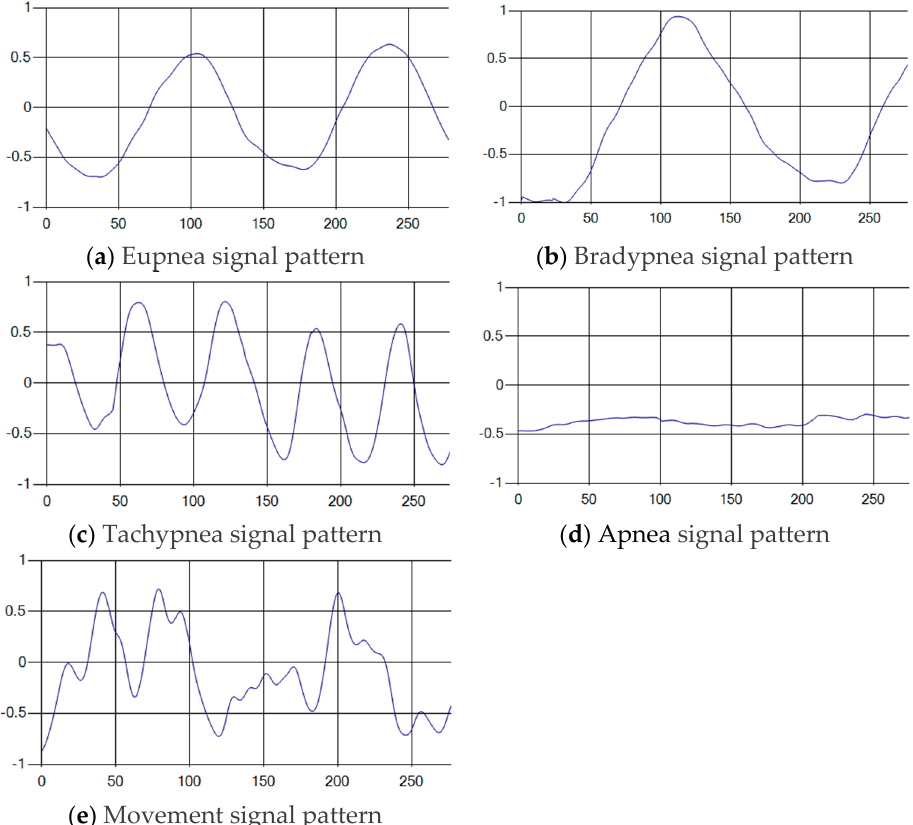
Figure 12. Five signal patterns for learning.